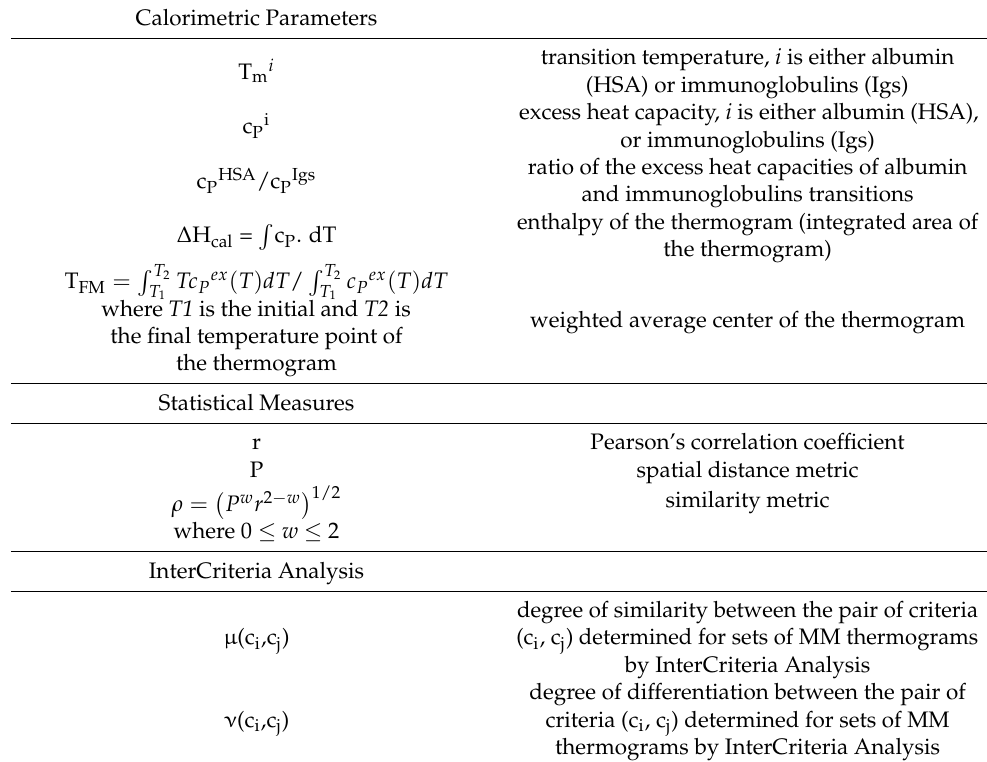
Table 1. Calorimetric parameters determined from blood serum DSC profiles, statistical measures describing the extent of resemblance between the “diseased” and control “healthy” calorimetric set of thermograms and degree of similarity/differentiation between pairs of criteria (ci, cj) determined for sets of (multiple myeloma) MM thermograms by InterCriteria Analysis. Calorimetric Parameters transition temperature, i is either albumin T m i excess heat capacity, i is either albumin (HSA),